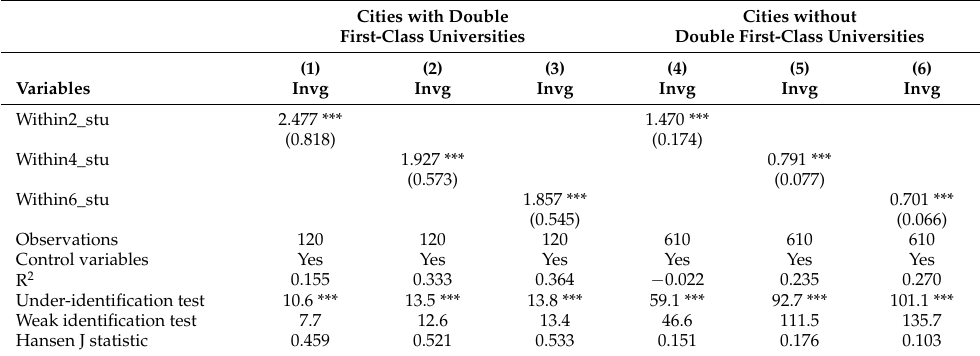
Table 8. The heterogeneous impact of double first-class universities on invention patents granted: government scientific funds.